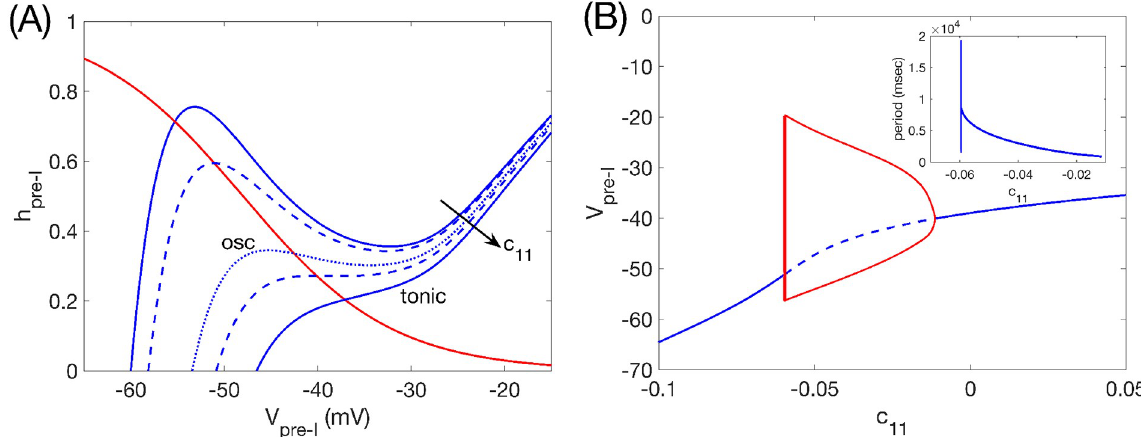
Fig 2. Pre-I tuning. (A): The V -nullcline structure for the pre-I unit in the preBo¨tC depends on its tonic drive parameter, c 11 . Blue curves pre − I denote the V -nullcline for several values of c 11 , with different line patterns used for contrast enhancement. The red curve is the h pre − I nullcline, which is independent of c 11 . A fixed point occurs where the two nullclines intersect. (B): Bifurcation diagram for the pre-I unit with respect to c 11 . Solid (dashed) curve denotes stable (unstable) equilibria. Red curves are max and min voltages along a family of stable periodic orbits; these grow extremely rapidly in amplitude when they first appear, near c 11 = − 0.060. Pre-I is oscillatory where these orbits exist, on c 11 2 ( − 0.060, − 0.011). Inset shows dependence of periods on c 11 ; period jumps sharply from 0 at the onset of oscillations, drops abruptly, and then decays more gradually as c 11